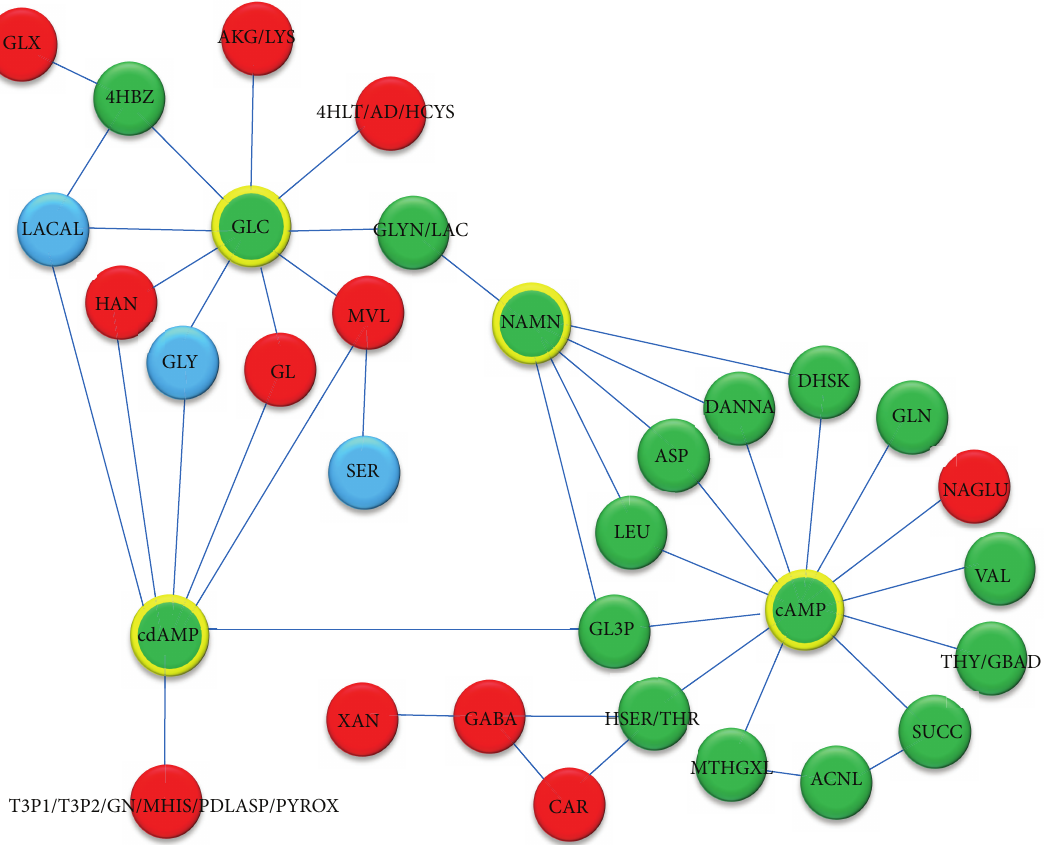
Figure 6: Key metabolite network on PC1; there are 32 key metabolites linking to each other with 4 hubs, that is, glucose, cyclic AMP, cyclic dAMP, and NAMN in PC1 network. These key metabolites can be used as PC1 to separate the sample taken from glucose culture from ethanol and glycerol cultures. Since there are 3 different patterns of changing in metabolite profile, these nodes are shown in 3 different colors; red (increasing), (decreasing), and blue (nonmonotonous or